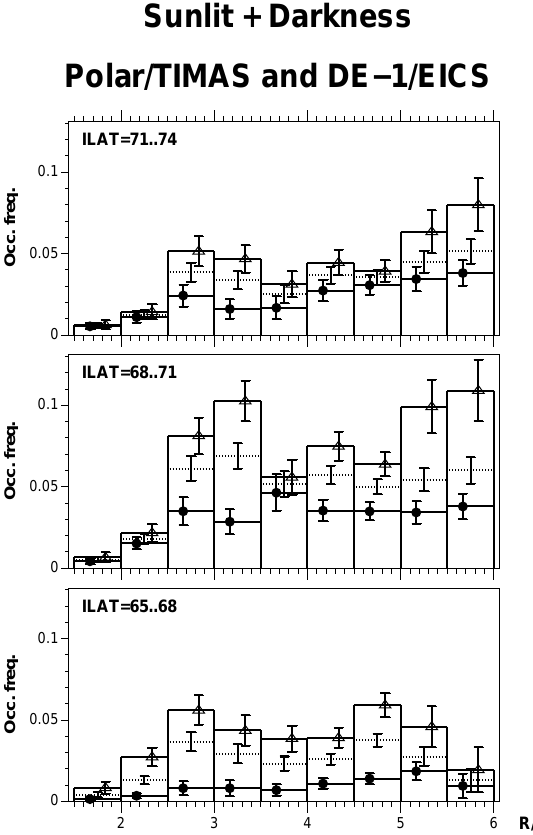
Fig. 6. Same as the bottom panel of Fig. 3, but shown separately for the ILAT ranges 71–74 (top), 68–71 (middle) and 65–68 (bottom). All nightside MLT sectors (18–06) are put together, and both sunlit and darkness conditions are included.